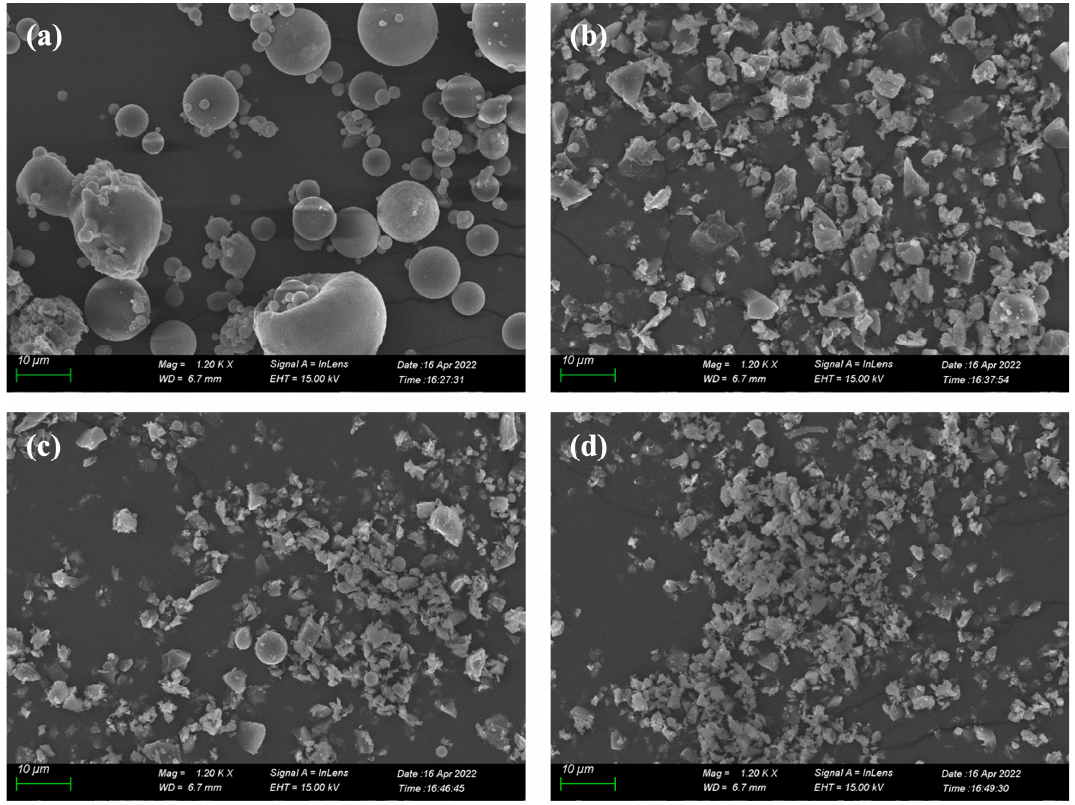
Figure 8. SEM microstructures of the CFA sample after grinding for 0 to 60 min ( a – d ).